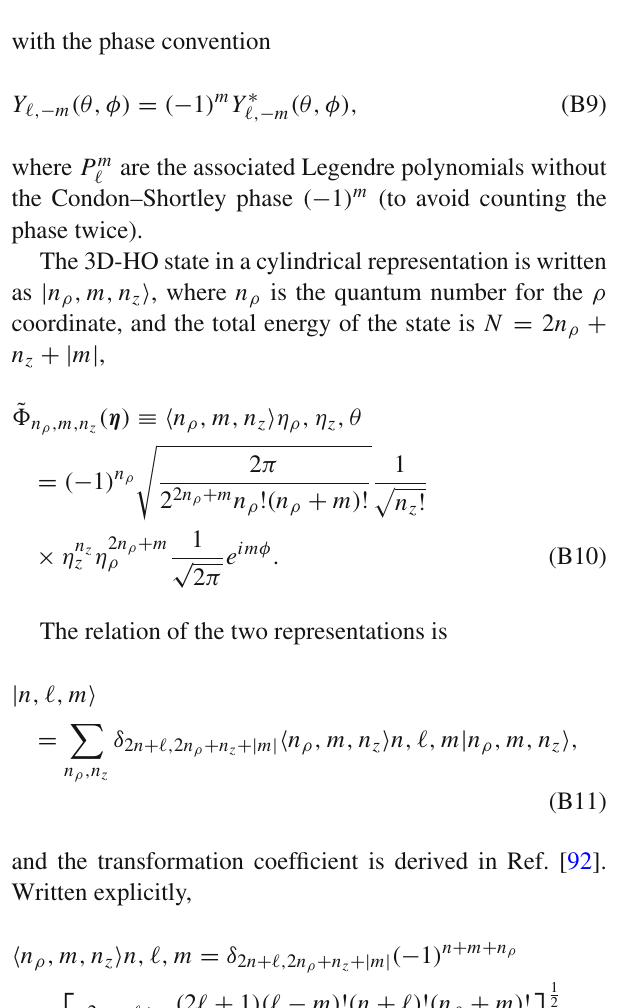
Table 9 The transformation of S waves (states with (cid:16) = 0) from the spherical coordinate to the cylindrical coordinate State